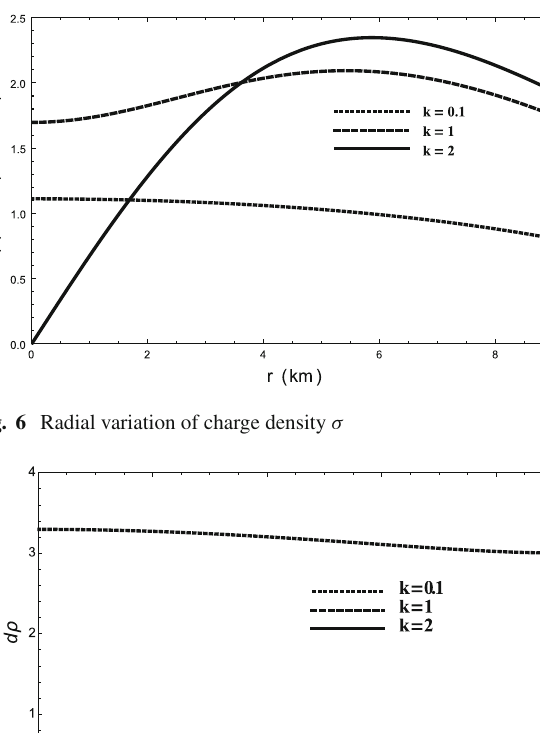
Fig. 5 Radial variation of electric field E 2 ( r )